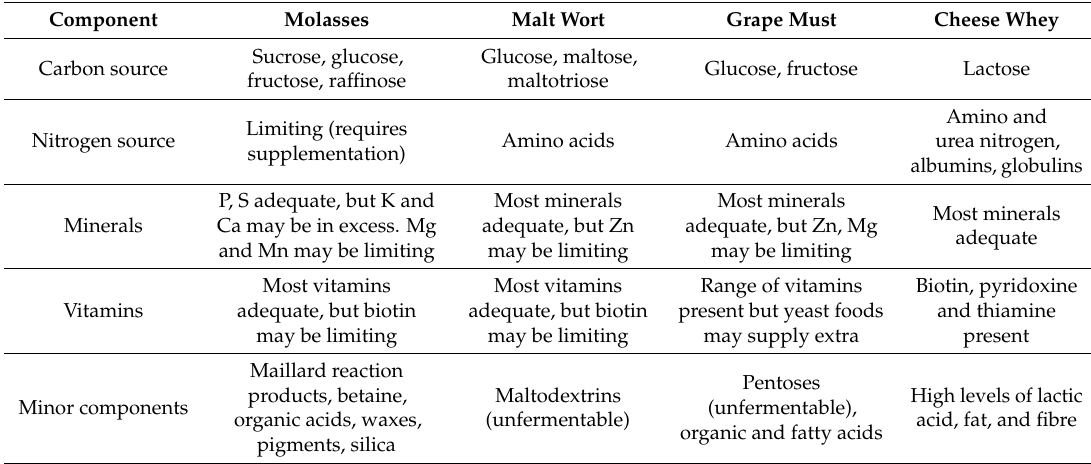
Table 3. Main components of selected fermentation media for production of alcoholic